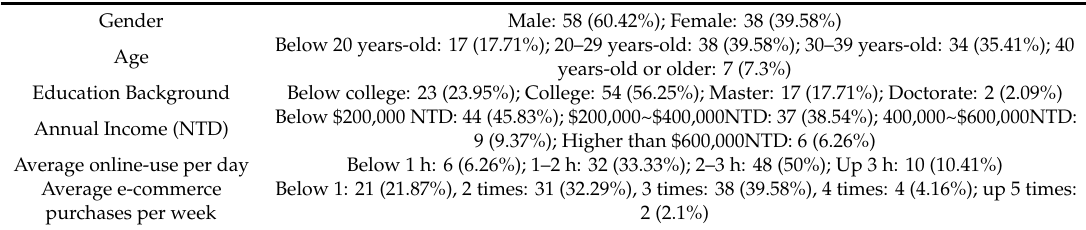
Table 1. Descriptive statistics of the 96 random surveyed e-commerce